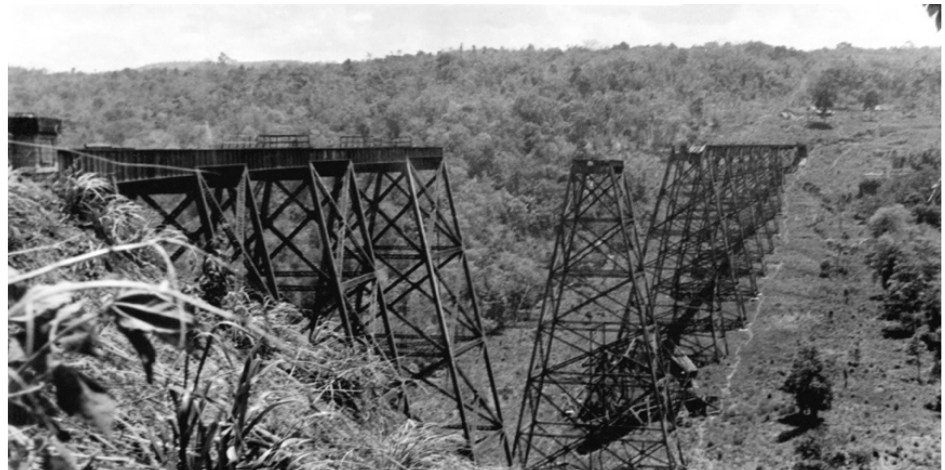
Figure 2. The Gokteik Viaduct after the end of the Burma campaign (c. 1947), with structural components missing. This photo was taken by the Burness family of Scotland as they traveled in Burma in the late 1940s. Source: (Wohlers 2022b).